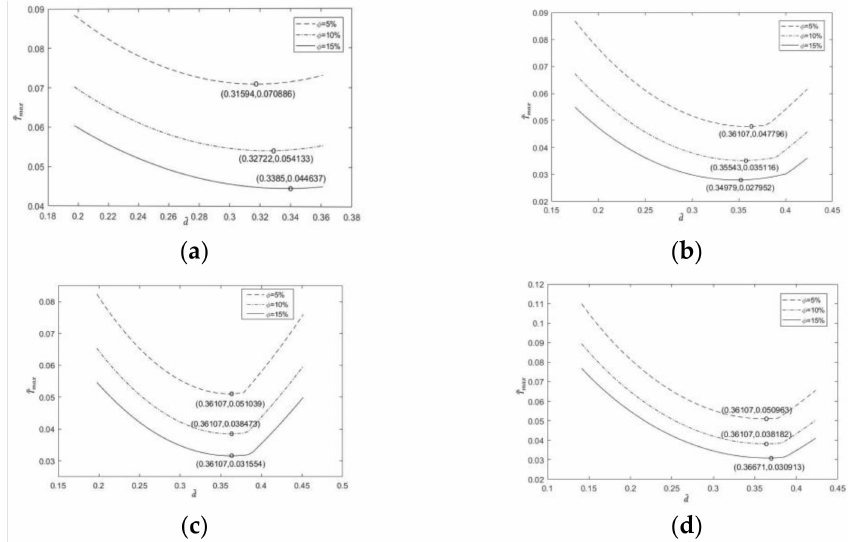
Figure 7. The relationship between ϕ and (cid:101) T max in four models at N = 2. Where subfigures ( a – d ) are Model 1, 2, 3 and 4 respectively.